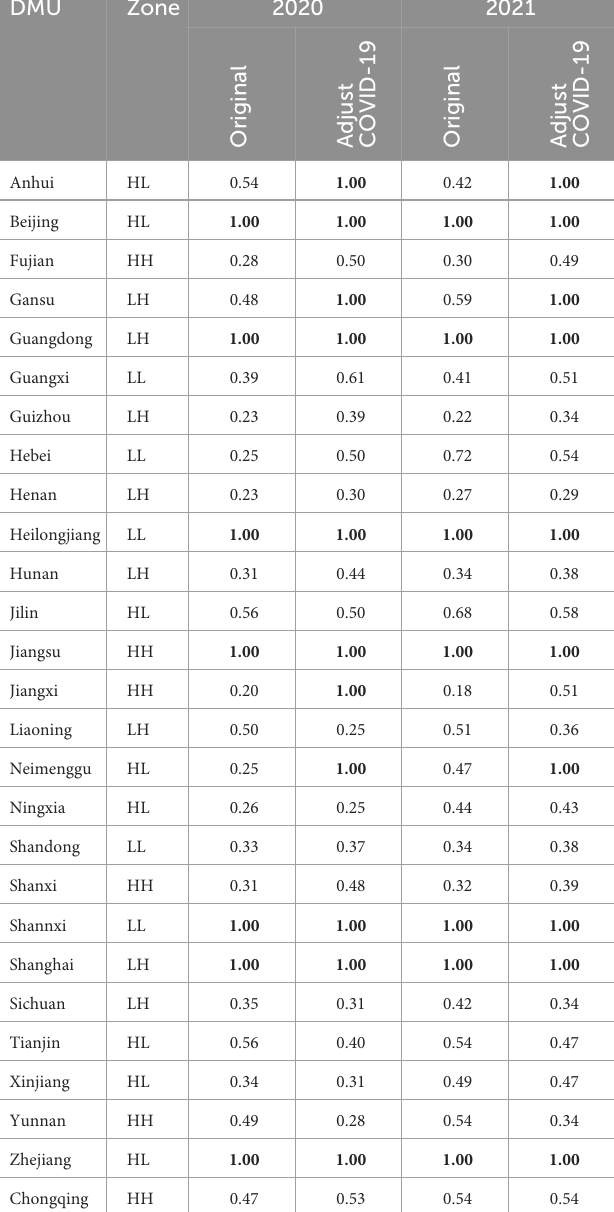
TABLE 9 Comparison of original efficiency and efficiency after environmental effect adjustment. DMU